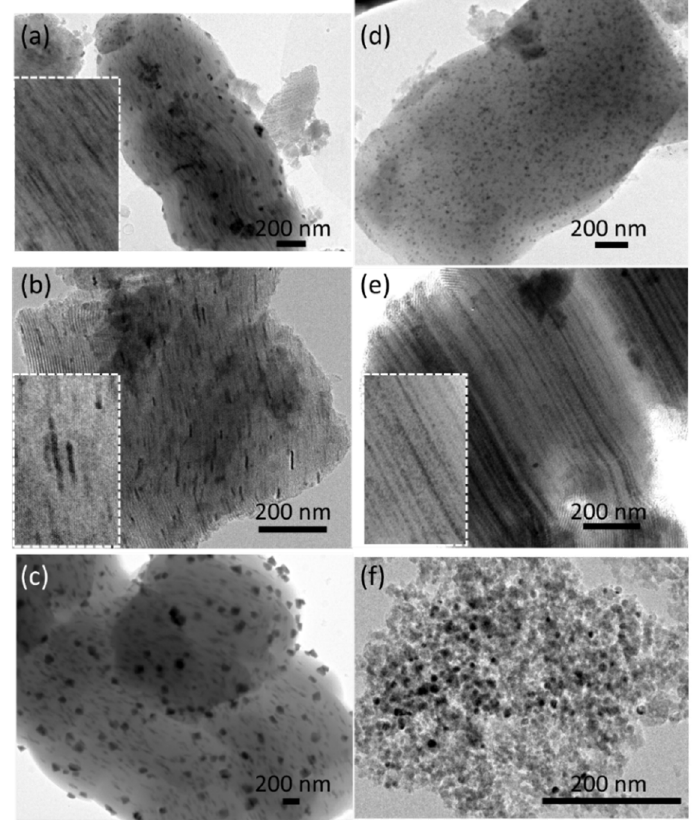
Figure 3. TEM images of the calcined ( a ) Ni/SBA-15(N), ( b ) Ni/SBA-15 HT (N), ( c ) Ni/SBA-15 HT (Cl), ( d ) Ni/SBA-15 HT (R), ( e ) Ni/SBA-15 com (N), and ( f ) Ni/SiO 2 (N) samples.